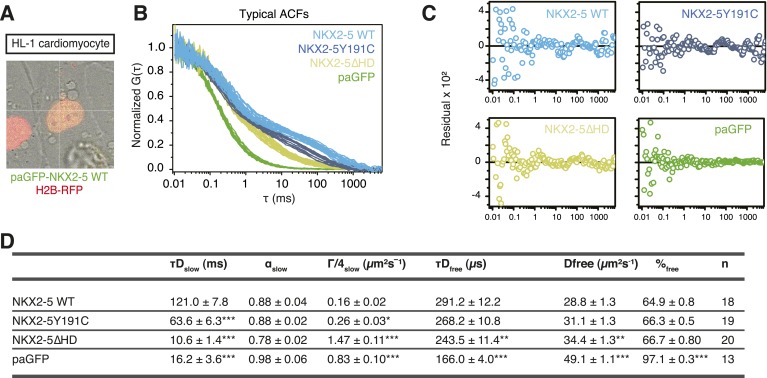
(A) Image showing paGFP-NKX2-5 and histone 2B-RFP fluorescence in a single HL-1 nucleus with fluorescence correlation spectroscopy (FCS) measurement performed at the crosshair point.(B) Typical ACF curves for each NKX2-5 WT and mutant proteins measured by paFCS in HL-1 cells. (C) Individual fit residuals for data shown in Figure 2C. (D) Summary of diffusion parameters for photoactivatable GFP (paGFP)-fusion proteins in HL-1 cells. Data are mean ± standard error of n measurements. τDslow, dwell time of the slow-diffusing component; αslow, anomalous parameter of the slow-diffusing component; Γ/4slow, transport coefficient for anomalous diffusion (G = 4D for non-anomalous diffusion) of the slow-diffusing component; τDfree, dwell time of the free-diffusing component; Dfree, diffusion coefficient of the free-diffusing component; %free, percentage of the free-diffusing component. Statistical significance indicated as ***, p < 0.0001; **, p < 0.001; *, p < 0.01 by Student's t-test for differences compared with NKX2-5 WT.